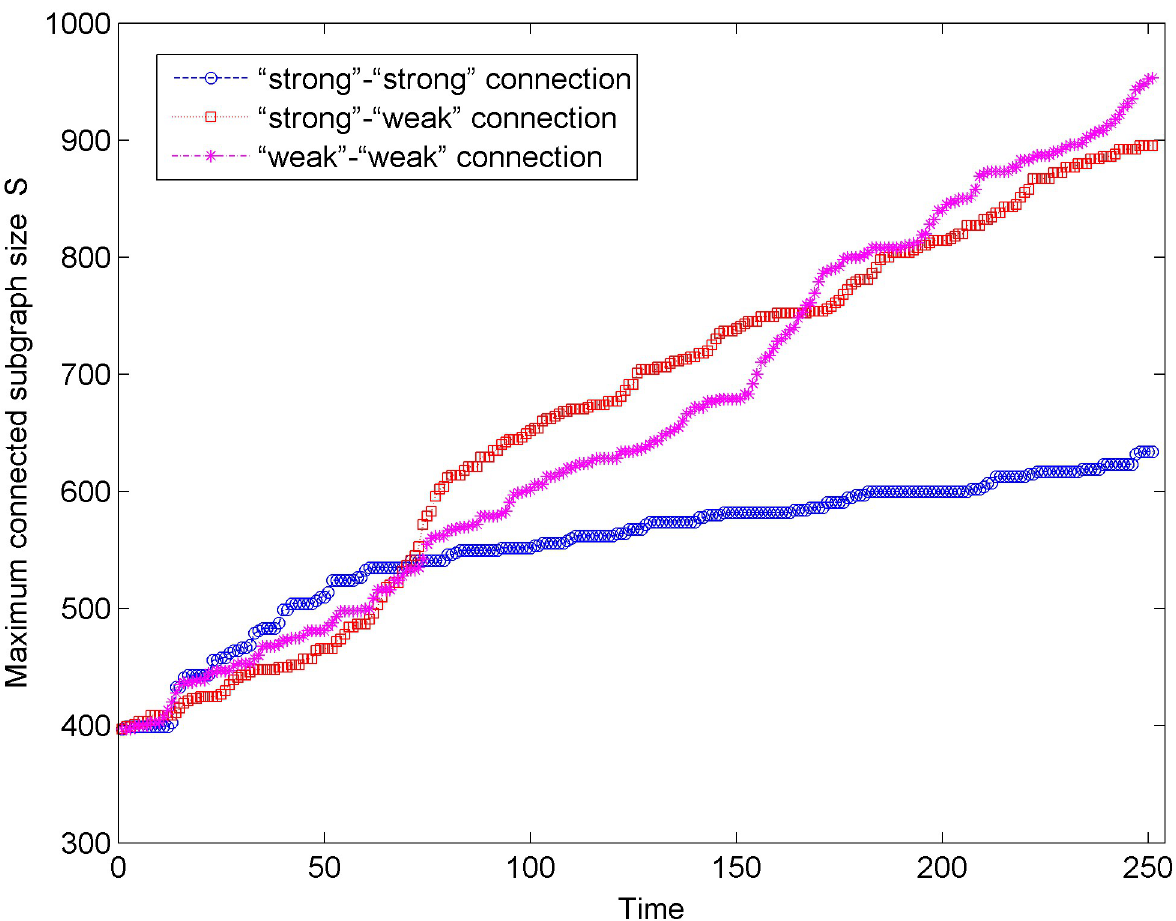
Fig 6. Changes of the maximum connected subgraph size in the unweighted